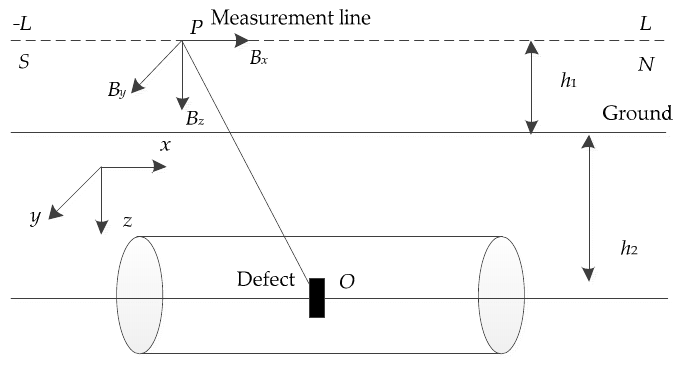
Figure 4. The pipeline defect model.